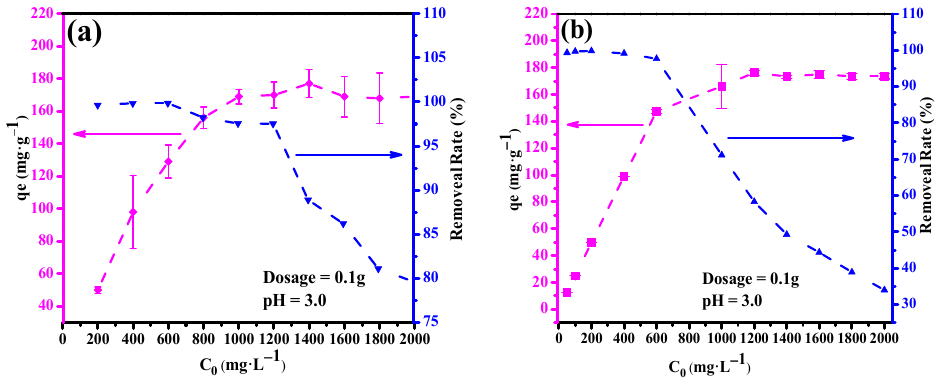
Figure 9. Effect of initial metal ion concentration on adsorption of Cu(II) ( a ) and Pb(II) ( b ) on